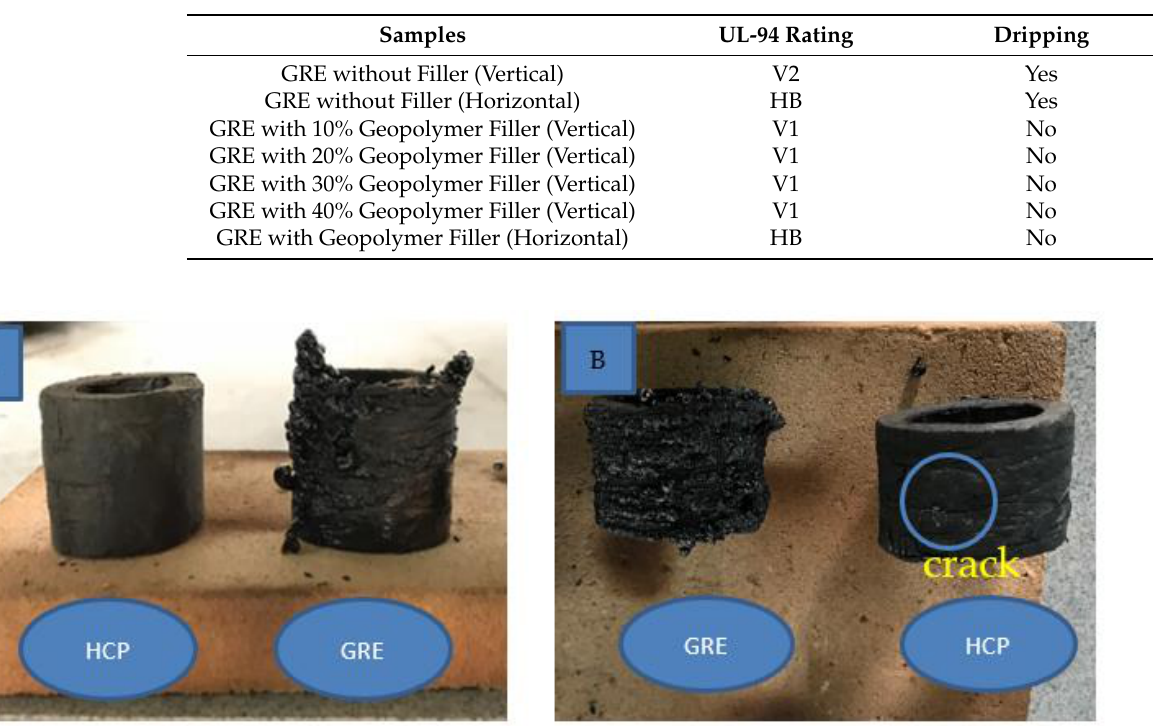
Table 5. UL-94 results of GRE without filler and GRE with high calcium pozzolanic-based geopolymer filler samples.